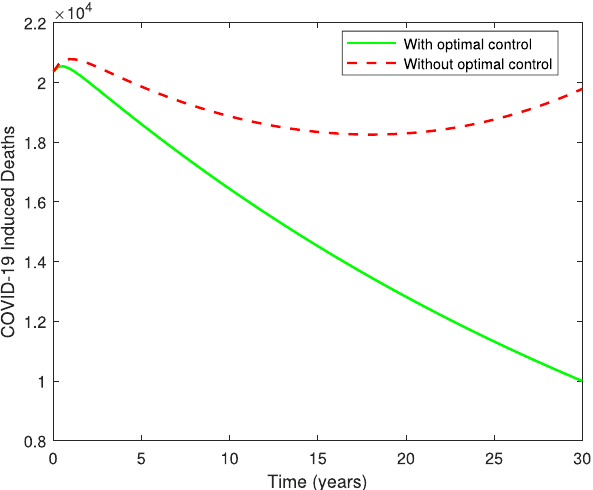
Figure 10. Graph illustrating COVID-19 induced death cases with and without optimal